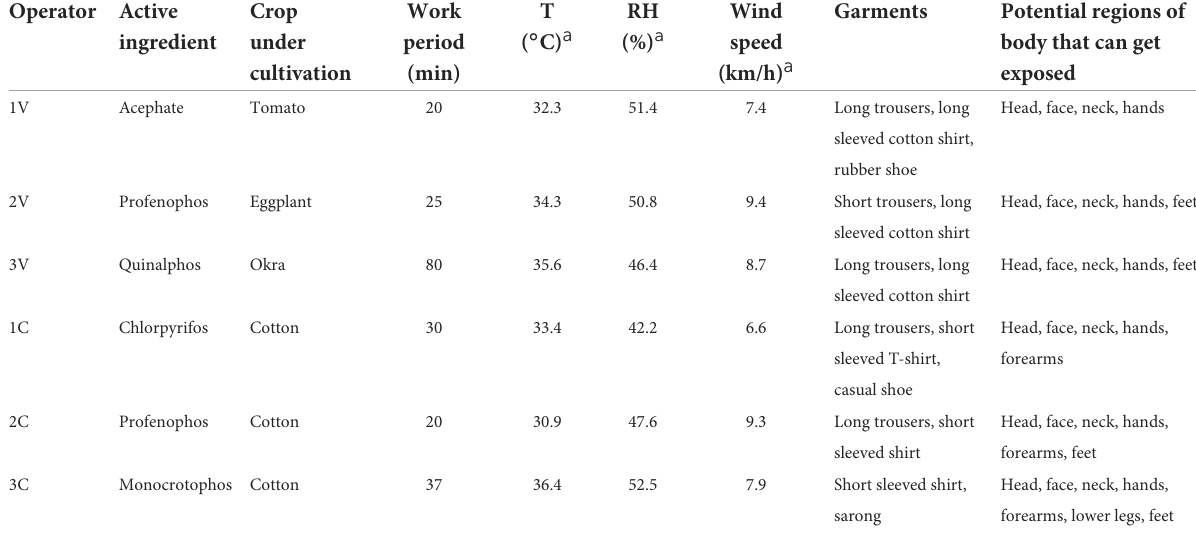
TABLE 5 Details of operational modalities for each pesticide treatment at the field level. Operator